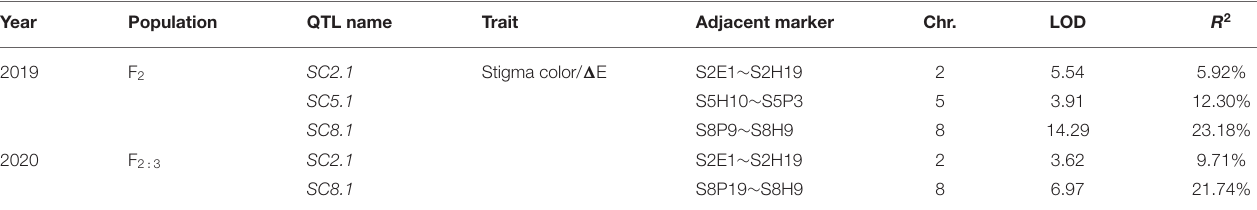
TABLE 2 | Quantitative traits locus (QTL) analysis of melon stigma color using F 2 population and F 2 : 3 population, respectively. Year Population QTL name